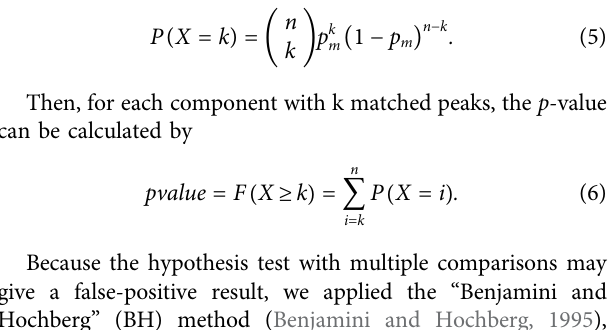
Frontiers in Chemistry |